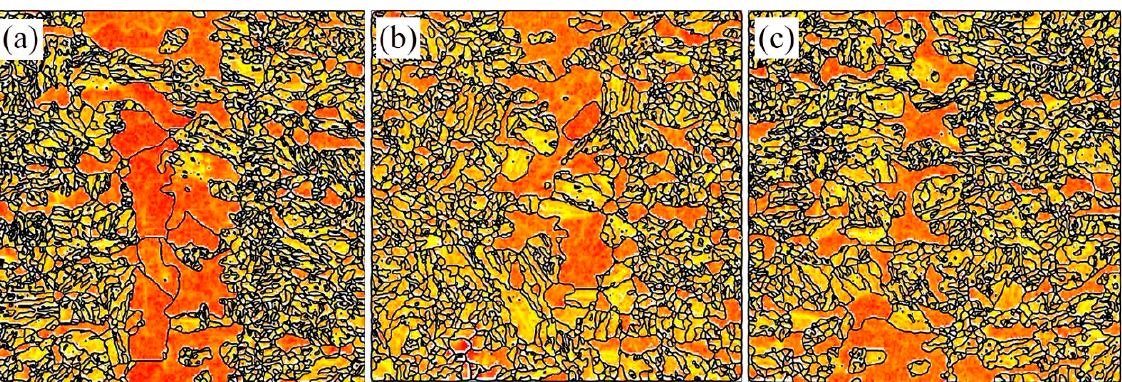
Figure 17. GND maps of the weld zone of creep samples for different stresses: ( a ) 3-550-160, ( b ) 3-550-180, and ( c ) 3-550-220.